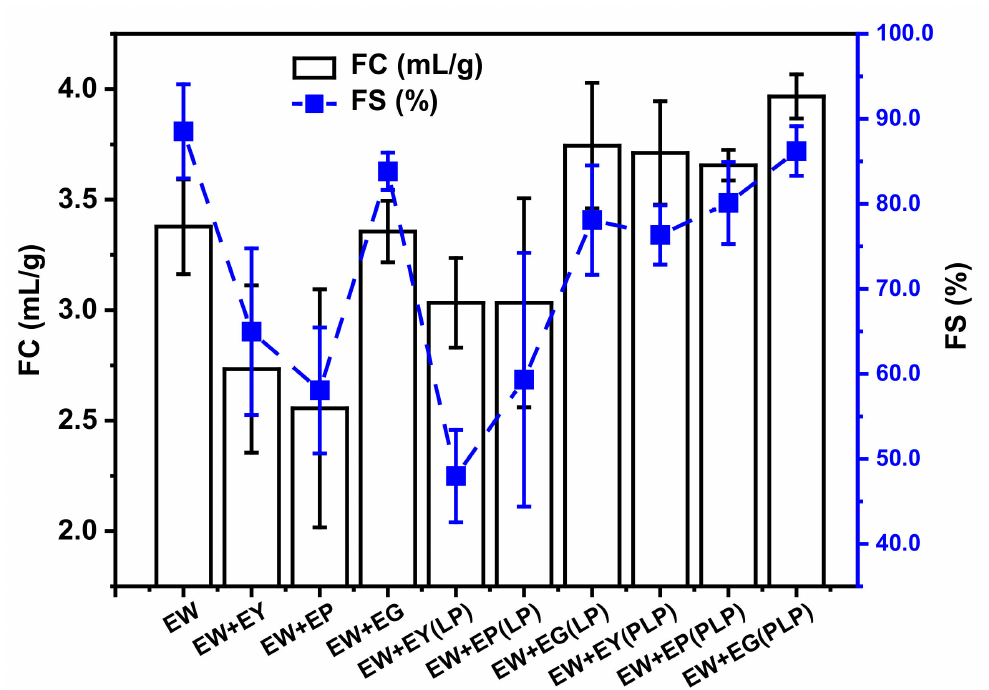
Figure 1. Foam capability (FC) and foam stability (FS) of egg white (EW) with egg yolk fractions, including egg yolk (EY), yolk plasma (EP) and yolk granule (EG) and their hydrolysates (hydrolyzed by lipase LP or phospholipase